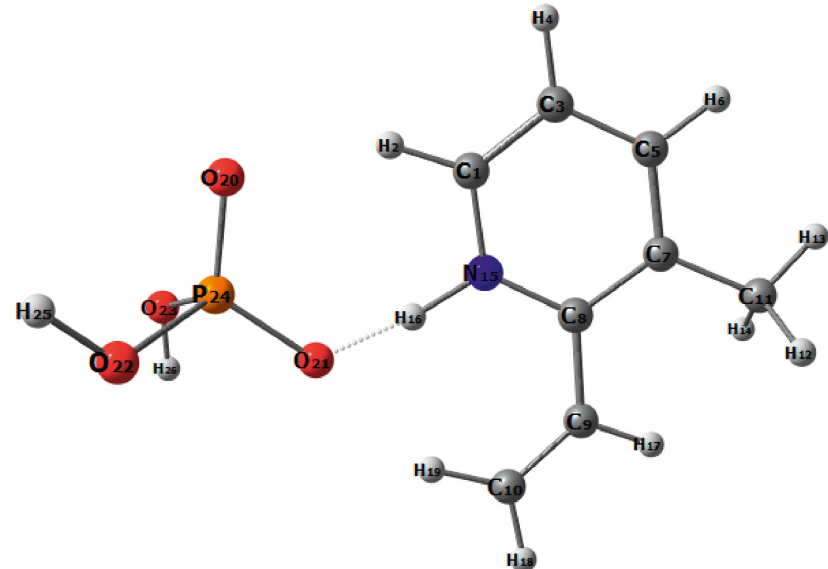
Figure 1: Optimized structure